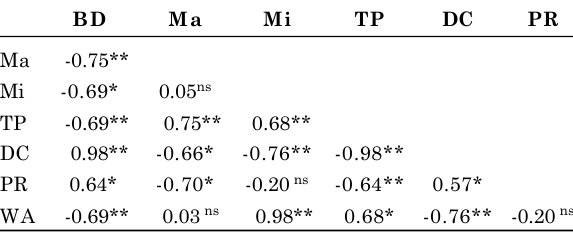
Table 2. Pearson correlation between physical and hydric properties of a soil under no-subsoiling and subsoiling treatments in a citrus orchard (n = 24)